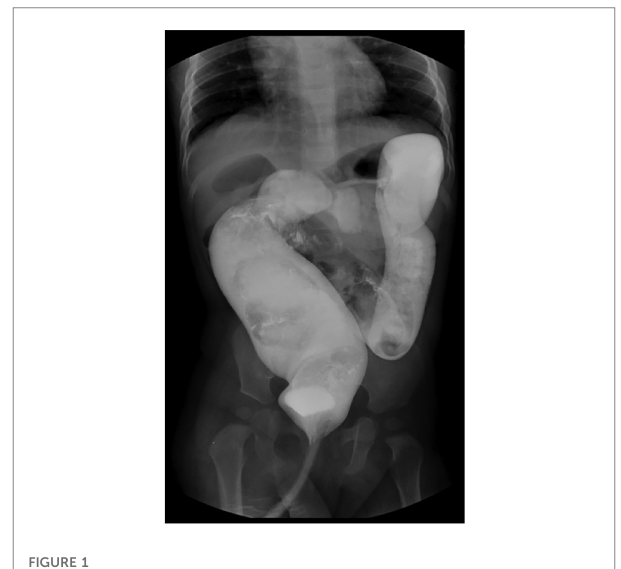
FIGURE 1 Barium enema indicates